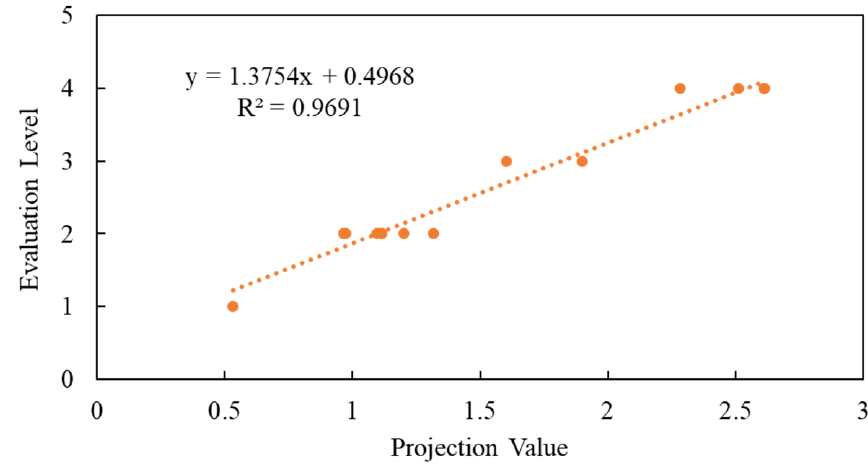
Figure 4. Relationship between projection value and evaluation grade.